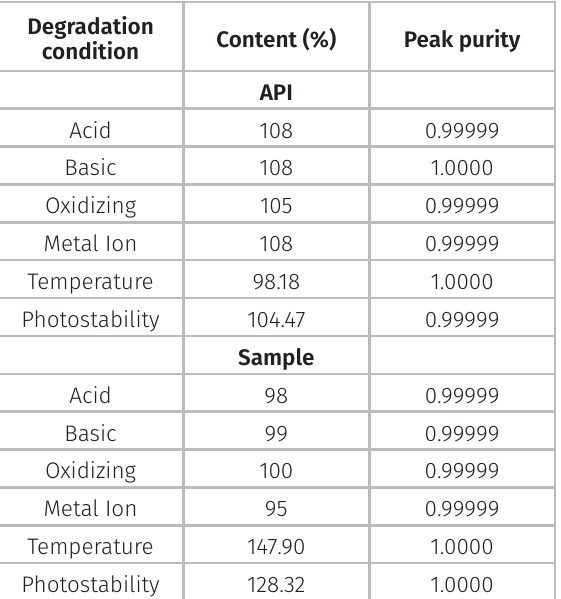
Table VI. Results of forced degradation. Degradation